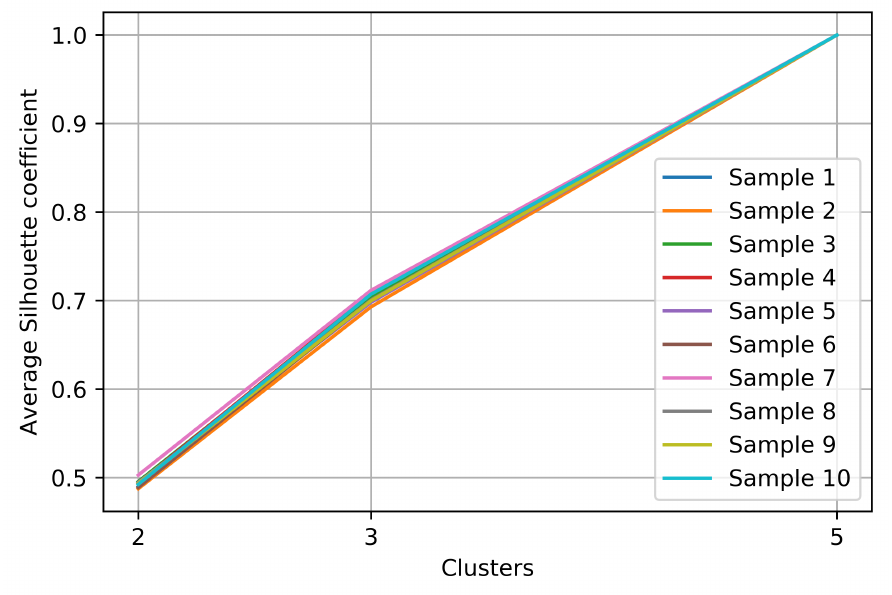
Figure 6. Silhouette coefficient by sampling